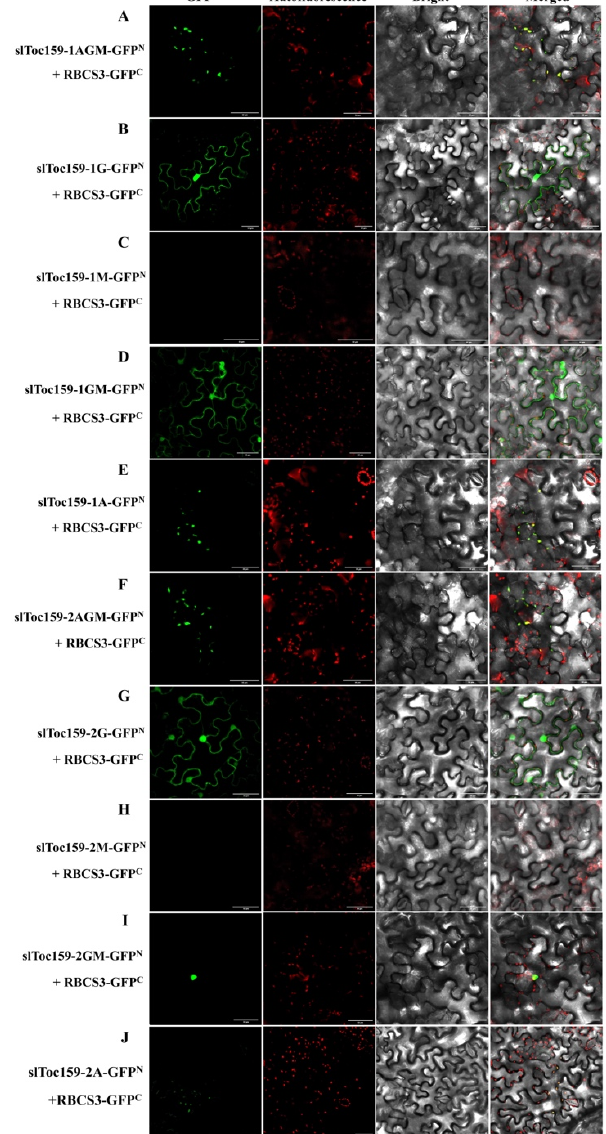
Figure 7. The interaction of different structural variants of slToc159-1 and slToc159-2 with RBCS3 in tobacco leaf epidermal cells. GFP, GFP fluorescence; Autofluorescence, chloroplast autofluorescence; Bright, bright-field image; and Merged, the merge of GFP, Autofluorescence. Bars = 50 µ